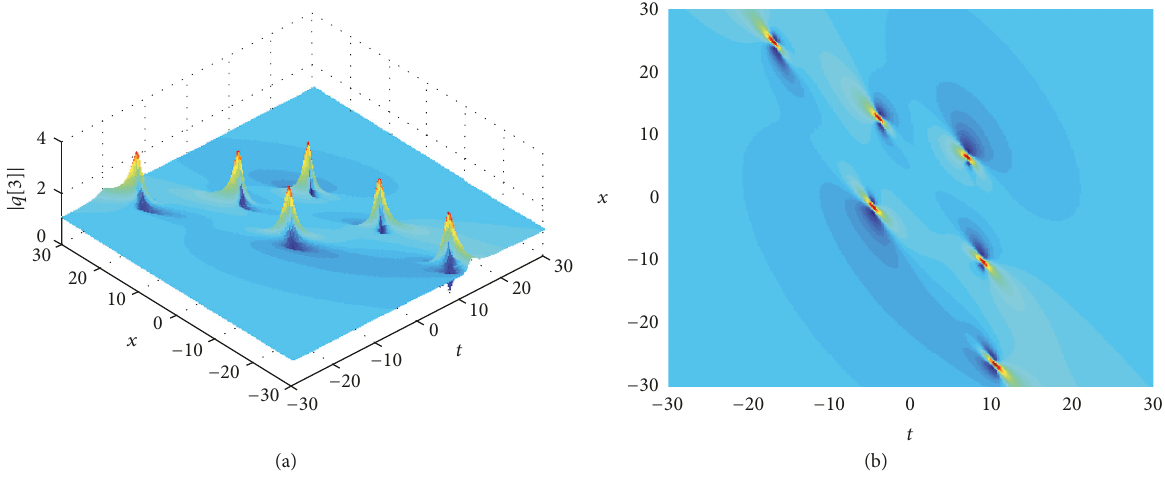
Figure 6: (a) The third-order rogue wave with 𝜀 = 0.25 and 𝑏 1 = 500 ; (b) the density plot with 𝜀 = 0.25 and 𝑏 1 = 500 .